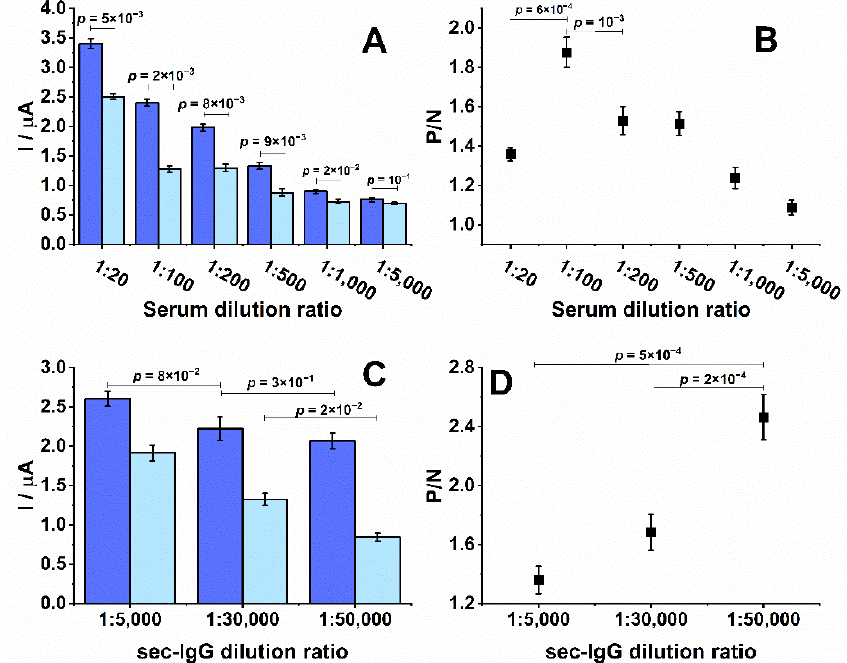
Figure 3. Optimization of primary and secondary antibody dilutions. All SPEs were sensitized with 100 µg/mL of EP2. ( A ) Peak currents measured over a dilution range of positive (blue) and negative (light blue) patient sera. ( B ) Ratio between positive and negative signals (P/N) from graph A. ( C ) Peak currents measured from positive (blue) and negative (light blue) patient sera diluted 1:100 in combination with a range of dilutions of the secondary antibody. ( D ) Ratio between positive and negative signals (P/N) from graph C. All experiments were performed in duplicate.